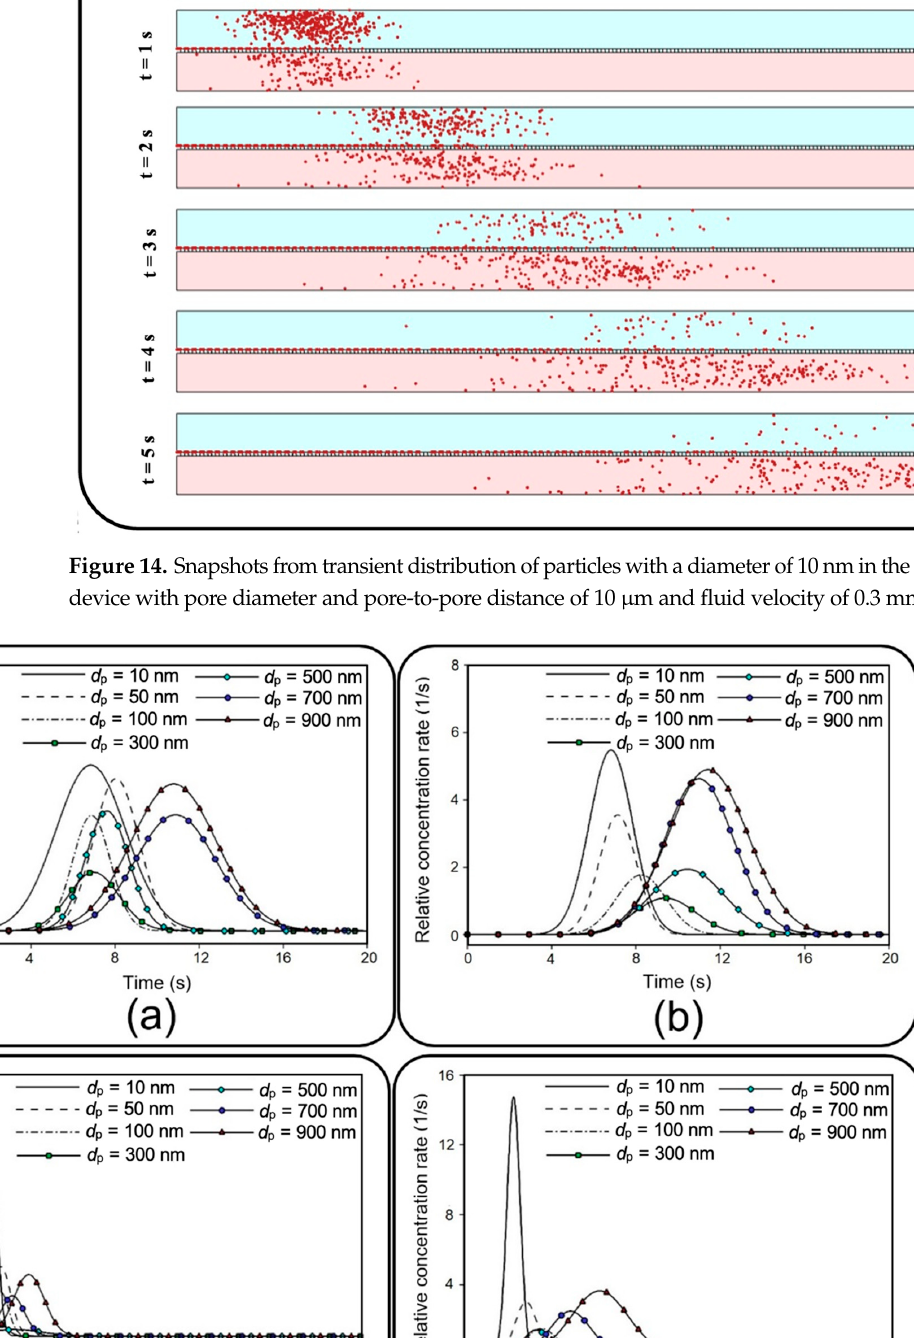
Figure 15. Transient relative concentration rate for NPs with different diameters. ( a ) 𝑑 = 3 µm, 𝑝 − 𝑝 = 10 µm; 𝑢 (cid:3028) = 0.3 mm/s; ( b ) 𝑑 = 10 µm, 𝑝 − 𝑝 = 5 µm, 𝑢 (cid:3028) = 0.3 mm/s; ( c ) 𝑑 = 3 µm, p − p = 10 µ m; u a = 0.3 mm/s; ( b ) d = 10 µ m, p − p = 5 µ m, u a = 0.3 mm/s; ( c ) d = 3 µ m, 𝑝 − 𝑝 = 10 µm, 𝑢 (cid:3028) = 1 mm/s; and ( d ) 𝑑 = 10 µm , 𝑝 − 𝑝 = 5 µm , 𝑢 (cid:3028) = 1 mm/s. p − p = 10 µ m, u a = 1 mm/s; and ( d ) d = 10 µ m, p − p = 5 µ m, u a = 1